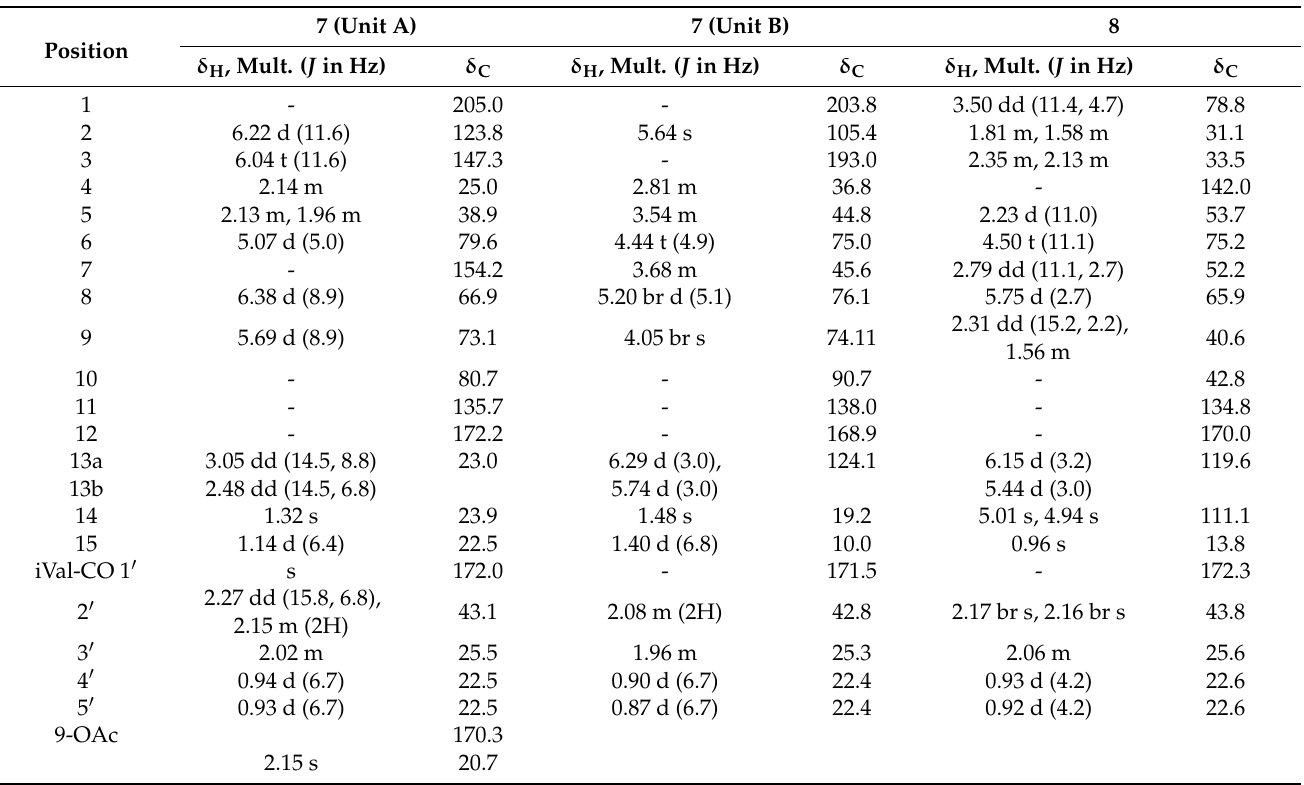
Table 3. 1 H (500 MHz) and 13 C (125 MHz) NMR data of compounds 7 and 8 in CDCl 3 ( δ in